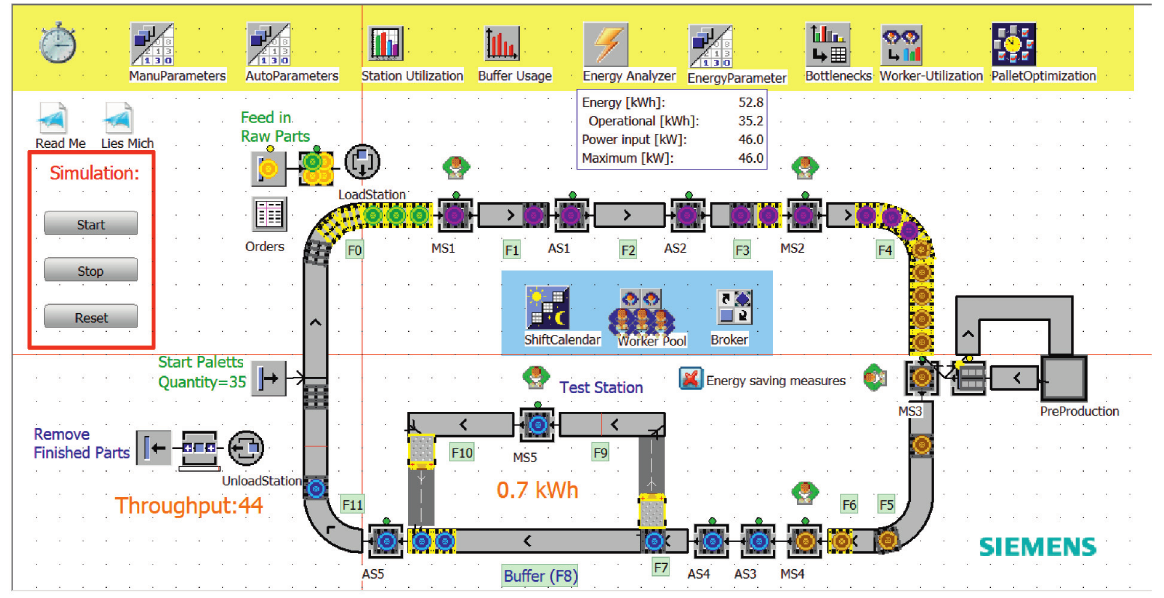
Figure 4: Model simulation